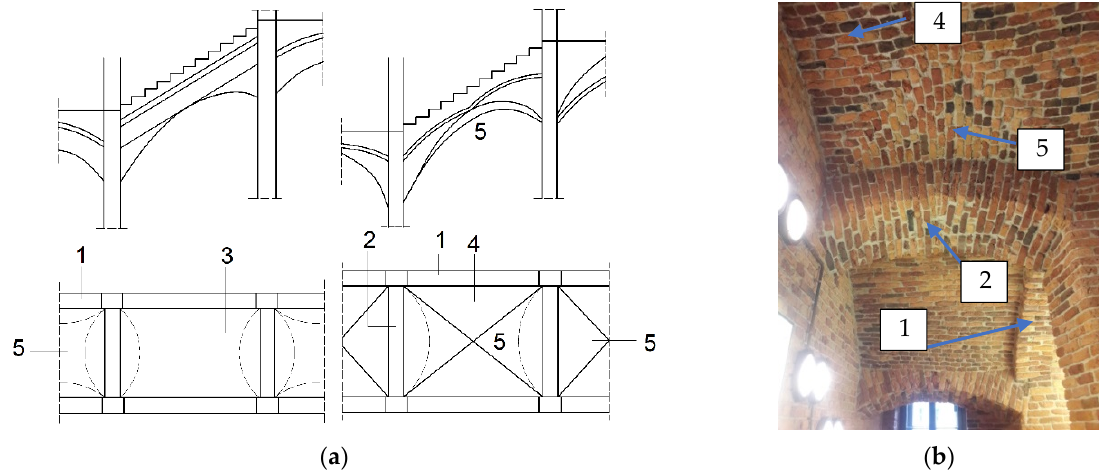
Figure 2. Brick stairs with column supports based on [1]. Scheme ( a ) and partial photo ( b ): 1—arched masonry stair sides; 2—arched masonry bolt; 3—barrel staircase with support on sides; 4—groin vault in stair flight; 5—groin or barrel vaults in stair landing.